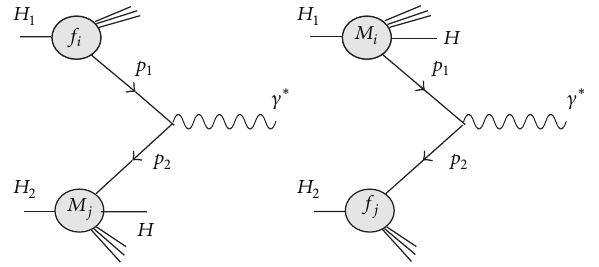
Figure 2: Pictorial representation of the parton model formula (4) for the associated production of a Drell-Yan pair and a particle in the target fragmentation regions.